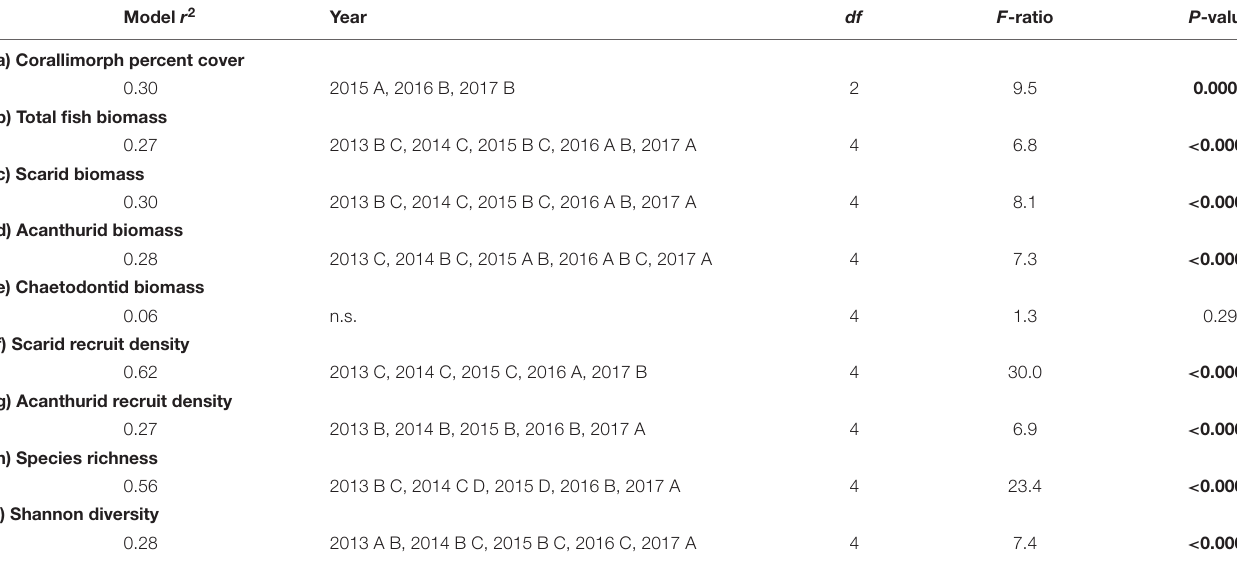
FIGURE 3 | Box and whiskers plot of the proportional cover of corallimorph on transects around the shipwreck site from 2015 to 2017. TABLE 1 | Results of ANOVAs testing the effect of year on (a) corallimorph cover, (b) total fish biomass, (c) scarid biomass, (d) acanthurid biomass, (e) chaetodontid biomass, (f) scarid recruit density, (g) acanthurid recruit density, (h) species richness, and (i) Shannon diversity at the site of the Hui Feng wreck. Model r